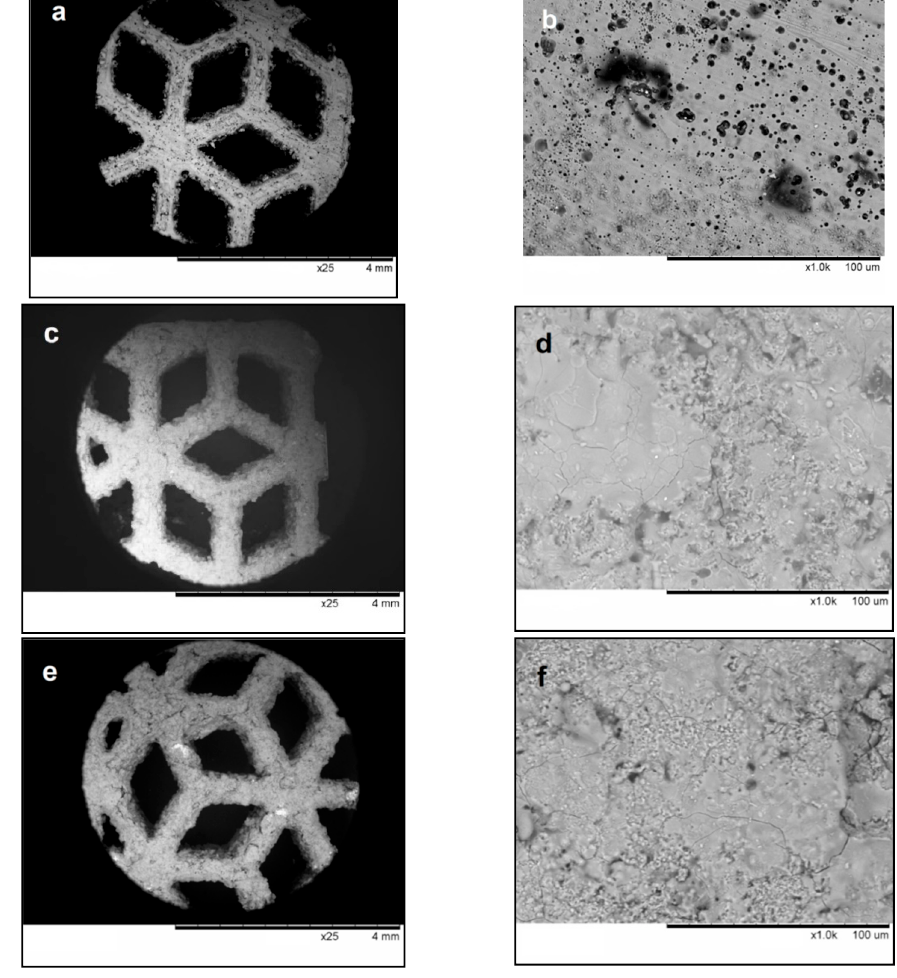
Figure 5. SEM images of the surface of the as-printed mesh plate ( a , b ) and plates coated by nano-HA ( c , d ) and calc-HA ( e , f ). General view ( a , c , e ) and surface morphology ( b , d , f ).